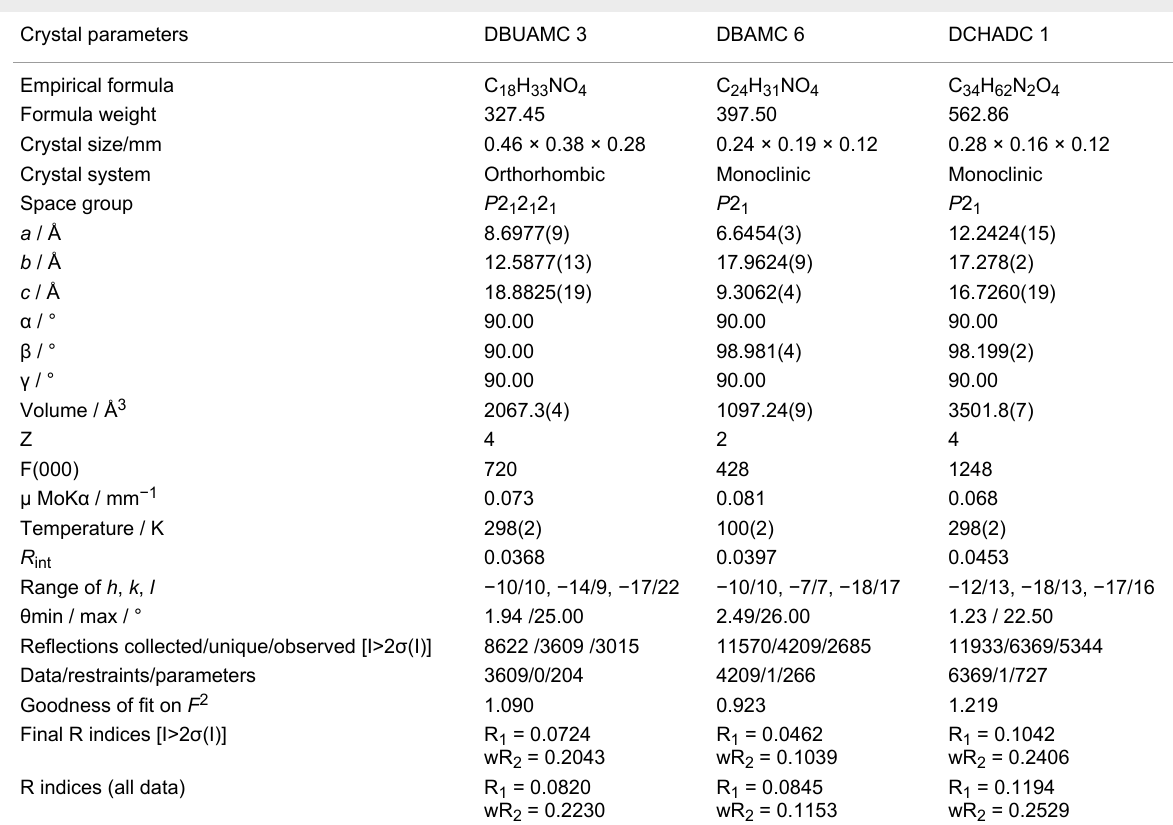
Table 2: Crystallographic data.